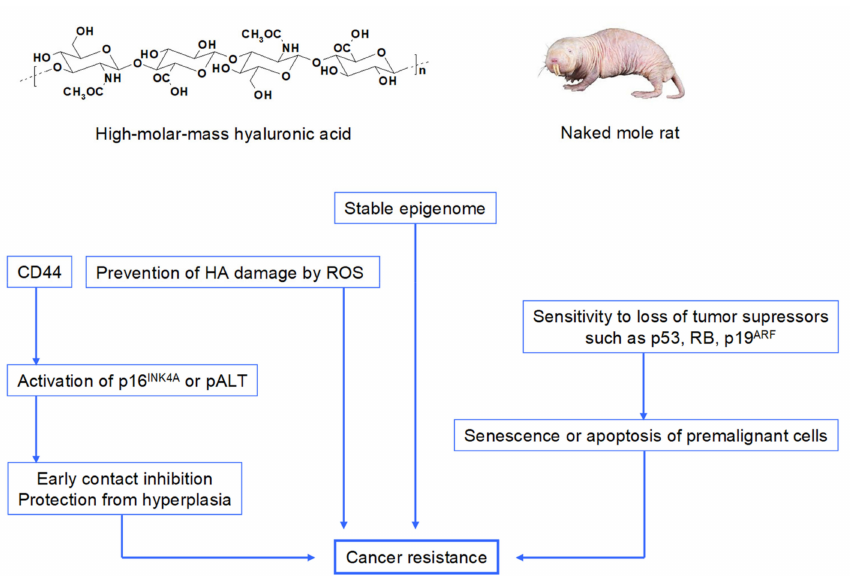
Figure 1. Anticancer mechanisms in the naked mole rat. HMM HA interacts with CD44 receptors and promotes early contact inhibition of naked mole rat fibroblasts via activation of p16 INK4A (a protein involved in regulation of the cell cycle) or the naked mole rat specific product of the Cdkn2 gene locus, pALT. Early contact inhibition provides protection from cancer by arresting the cell cycle at a low cell density and preventing hyperplasia. HMM HA may also provide protection from metastasis by maintaining a stronger ECM. HMM HA also acts as an antioxidant, thereby reduces ROS-induced damage to nucleic acids and proteins. Furthermore, this animal has a unique ability to sense the loss of a single tumor suppressor such as p53, RB or p19 ARF and undergoes apoptosis or senescence (adapted from Seluanov et al.